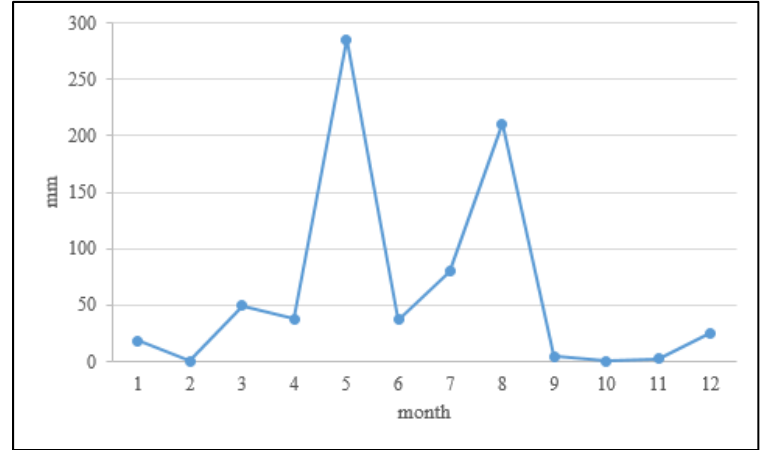
Figure 2. Monthly cumulative rainfall statistics chart during the sampling period.